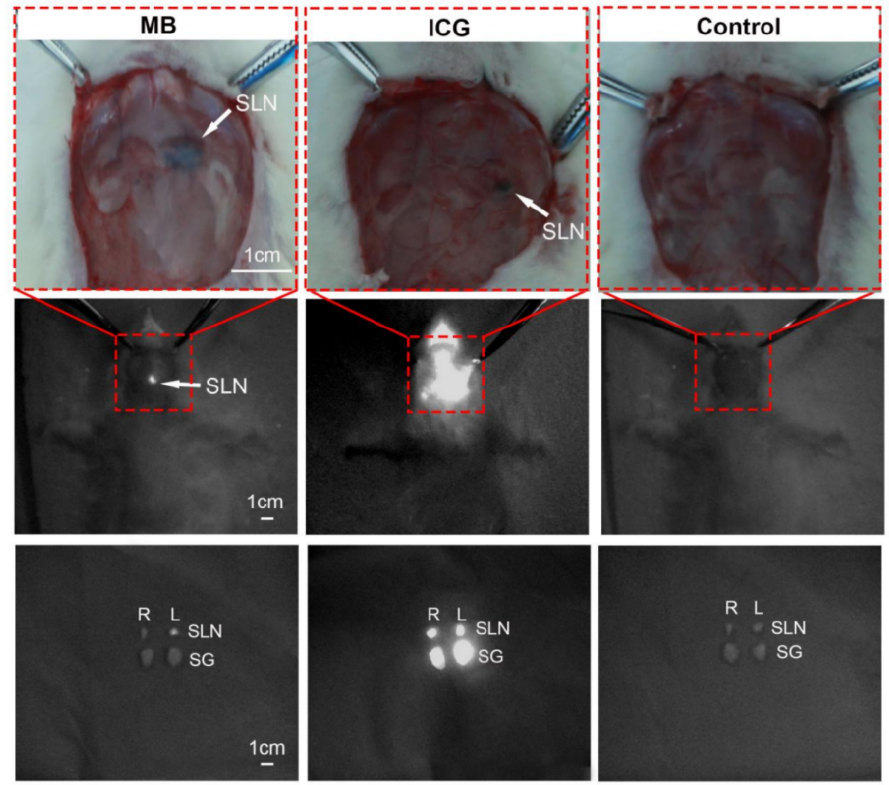
Figure 4. Bright-view images ( top ) and NIR fluorescence images ( middle ) of the neck of rats at 12 h after the injection of MB, ICG, and saline. NIR fluorescence images ( bottom ) of different tissues from the rats at 12 h after injection of MB, ICG, and saline. SLN = sentinel lymph node, SG = salivary gland, R = right, and L = left.